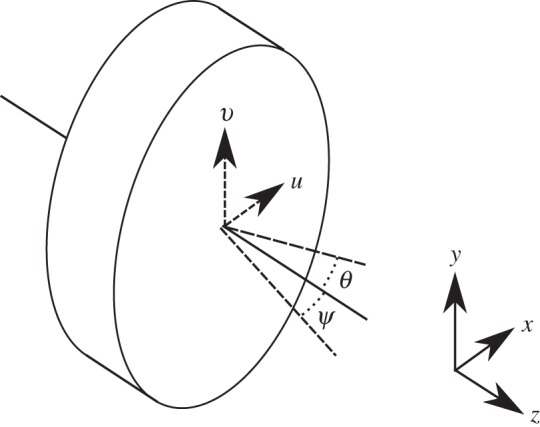
Coordinate system.